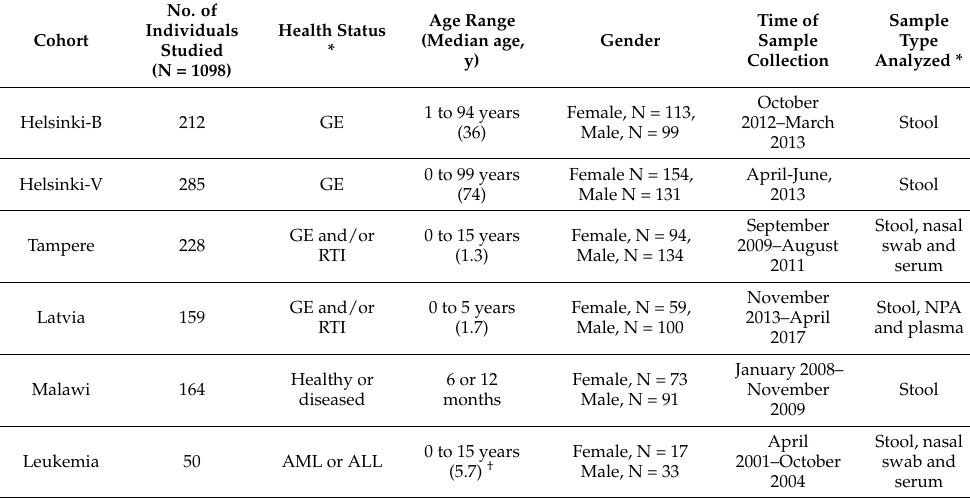
Table 1. Characteristics of cohorts used in the current